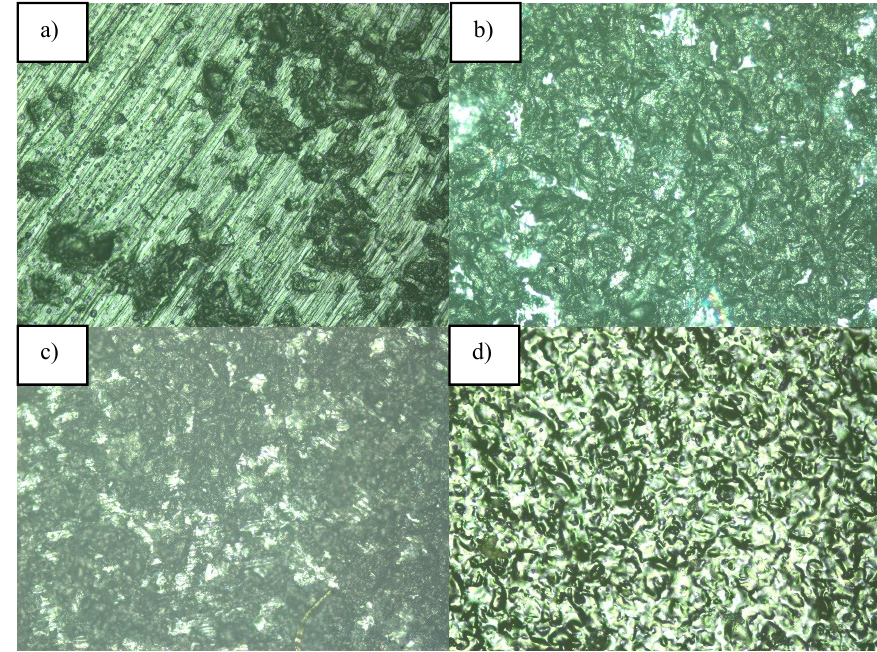
Figure 4. Optical images (×100) of the non ‐ aged samples ( a ) LS10, ( b ) LS11, ( c ) LS20, and ( d ) LS21. Material processing is visible only for LS10 ( a ).